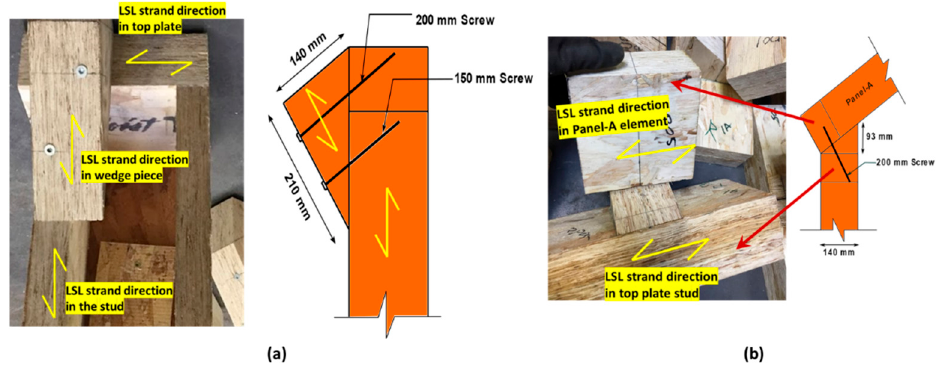
Figure 28. Strand direction in: ( a ) Connection-B; ( b ) Connection-A.